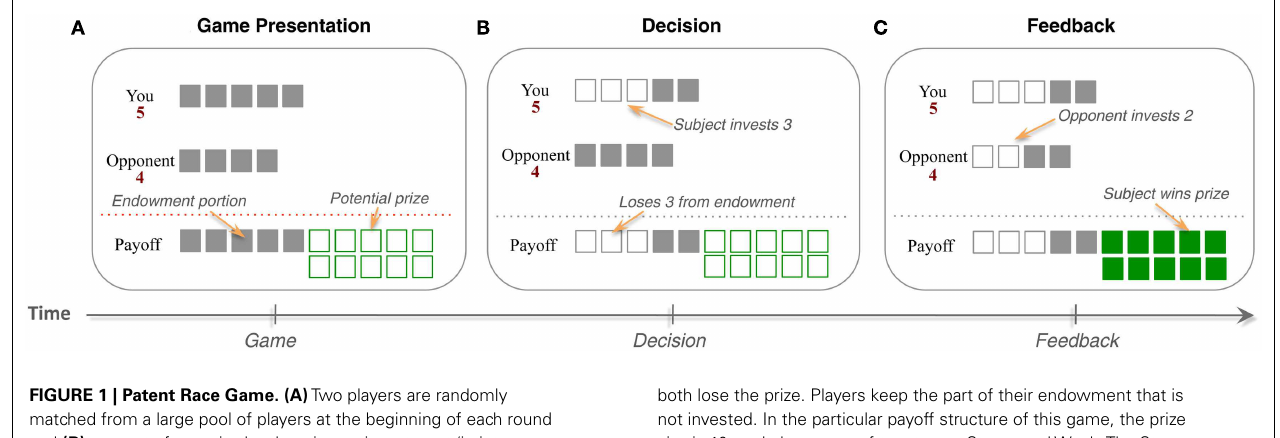
FIGURE 1 | Patent Race Game. (A) Two players are randomly matched from a large pool of players at the beginning of each round and (B) compete for a prize by choosing an investment (in integer amounts) from their respective endowments. (C) The player who invests more wins the prize and the other loses. In the event of a tie,